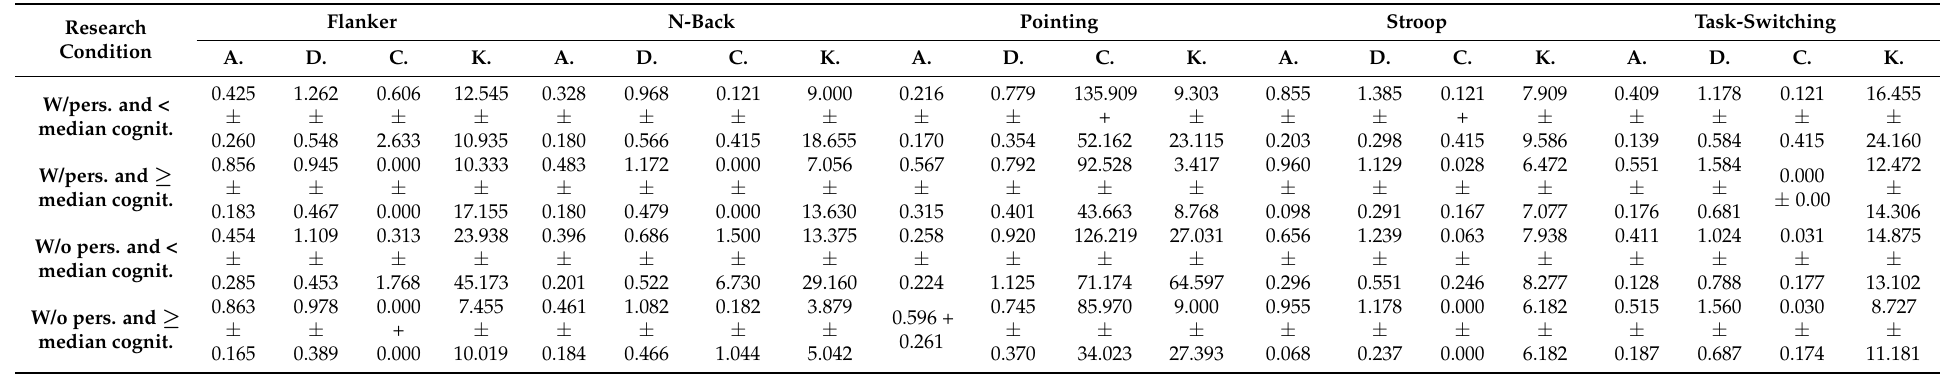
Table 2. Results of the cognitive tests, comprised of average and standard deviation values (both have 3 decimal digits) in the four research conditions of personalization and cognition (‘W/o’—without, ‘W/’—with, ‘pers’—personalization, ‘A.’—accuracy, ‘D.’—duration, ‘C.’—clicks, ‘K.’—key presses). Flanker N-Back Pointing Stroop Research Condition